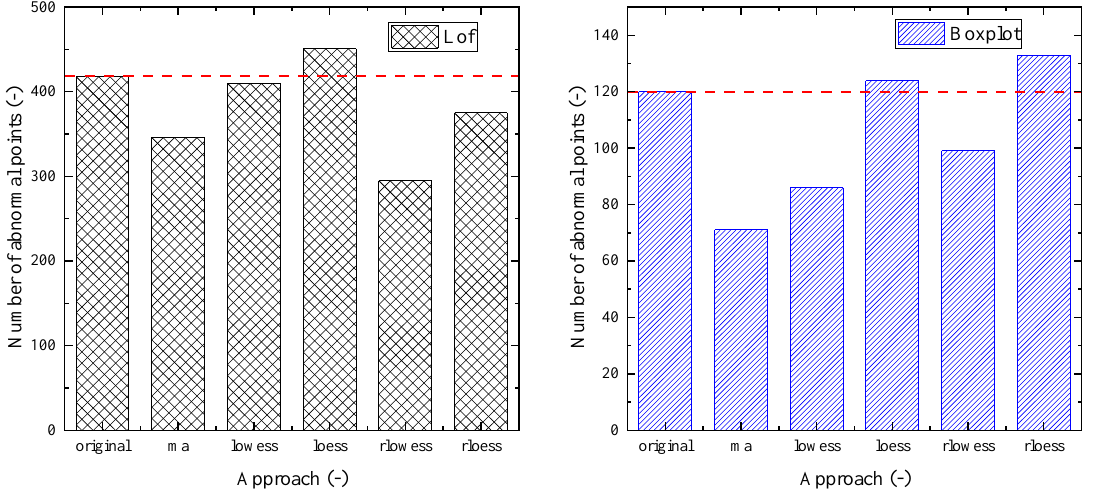
Figure 9. Outlier detection results of the different methods.